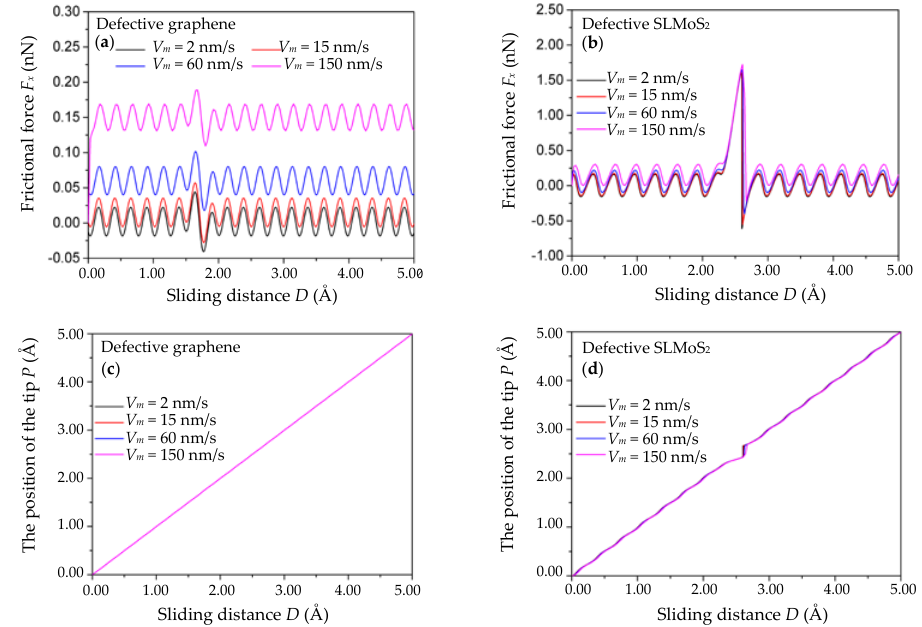
Figure 5. The frictional force F x vs. the sliding distance D curves of the monovacancy-defective graphene ( a ) and SLMoS 2 ( b ) with different sliding velocities V m . The position of the single-atom tip P vs. the scanning distance D curves of the monovacancy-defective graphene ( c ) and SLMoS 2 ( d ) with different sliding velocities V m . The curves in Figure 5 look like a single curve, but they are the overlap of multiple curves, and the displayed curves are the pink curves.